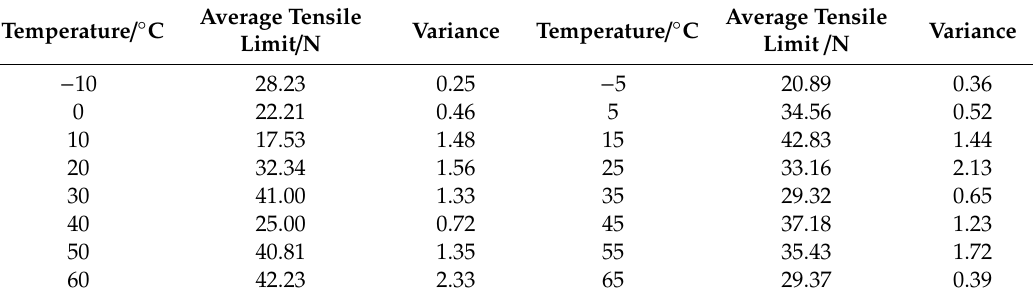
Table 7. Two-point tensile test tensile strength of the blades at each temperature.